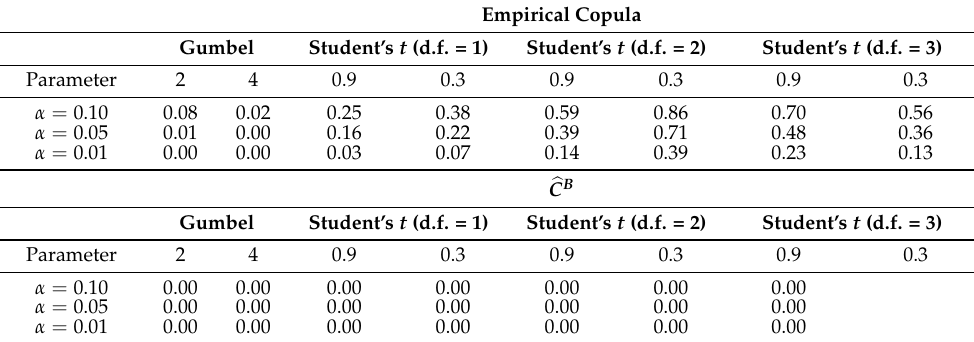
Table 3. Error type 1 calculated with different significant levels α .